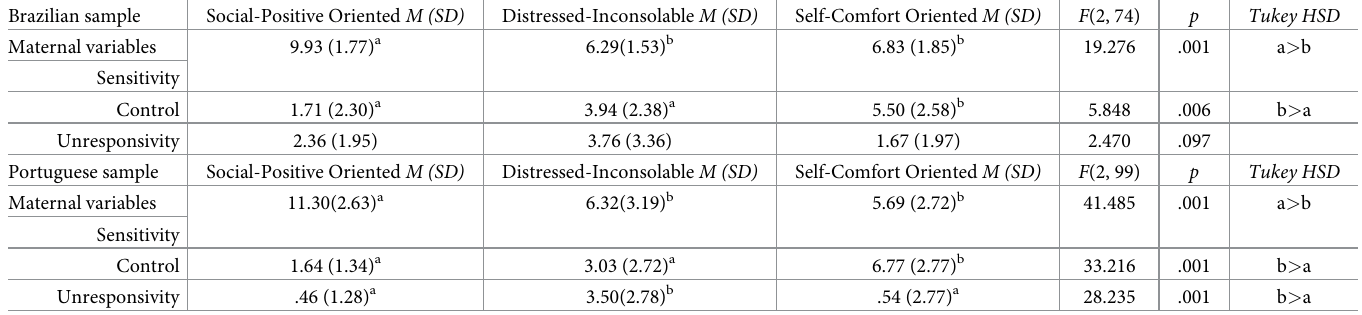
Table 4. Means, standard deviations, and ANOVA results for ratings of maternal behavior in free play at 3 months, according to patterns of infant regulatory behavior at 3 months. Brazilian sample Social-Positive Oriented M (SD)